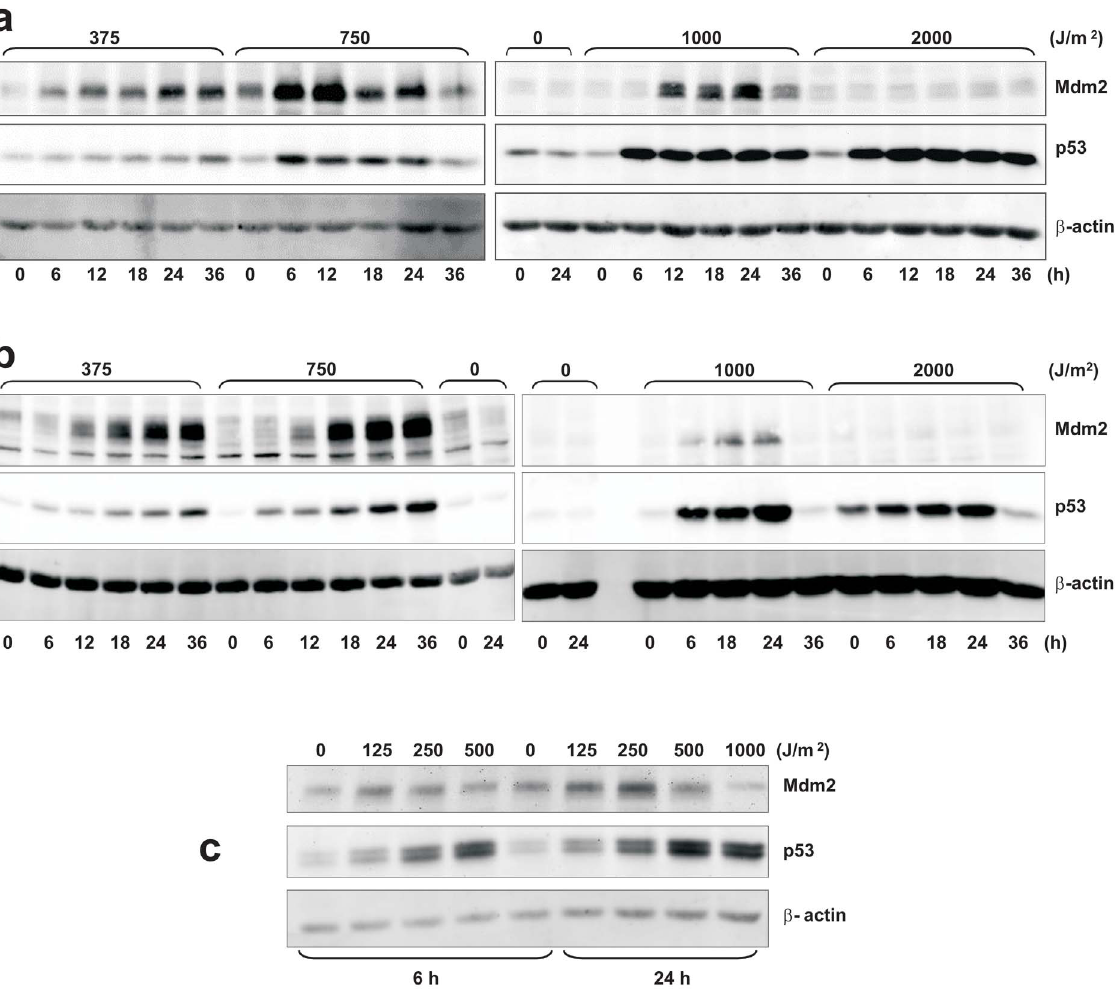
Figure 4. Western blot detection of p53 and Mdm2 proteins: FHN (a), XP-C (b) and CS-B (c) fibroblasts were irradiated with the indicated doses of UVB and collected at the time intervals shown. Beta-actin was used as loading control.